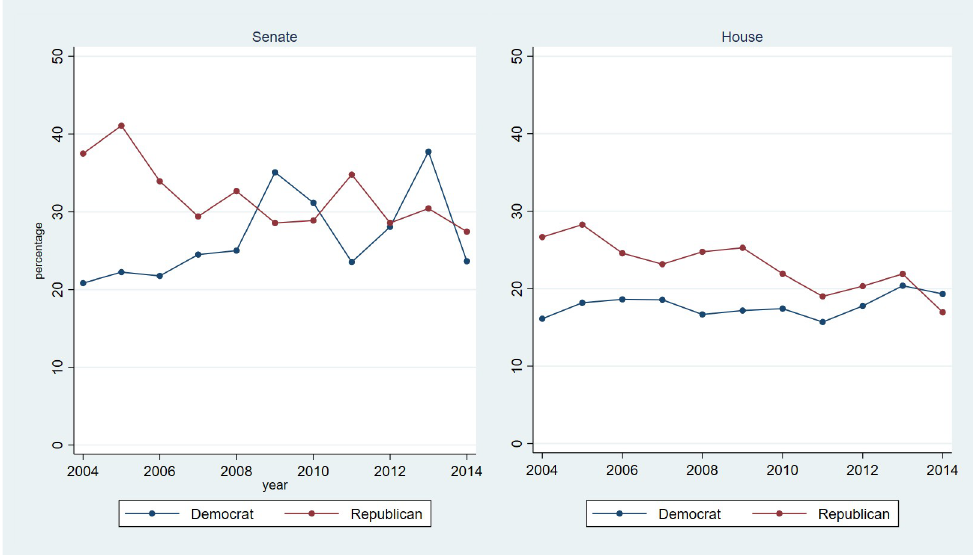
Fig 1. Share of members holding health care-related